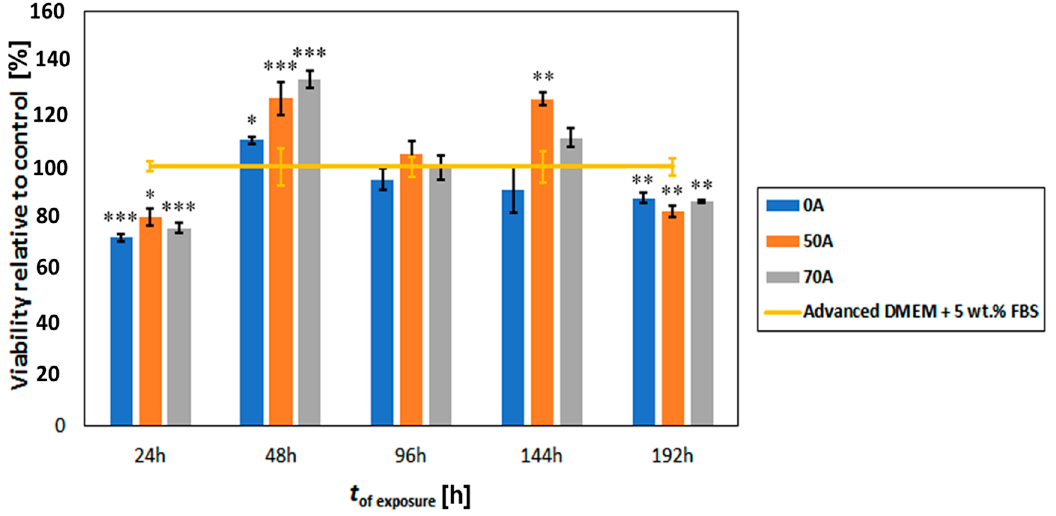
Figure 7. Osteoblast cytocompatibility (proliferation behaviour) with 0A, 50A and 70A chitosan– cellulose hydrogel beads based on the MTT assay over the timeframe of 192 h. Values are expressed as percentage of the means ± SD ( n = 4). Statistical significance was defined as * p < 0.05, ** p < 0.005, *** p < 0.001 as compared to control sample (ANOVA